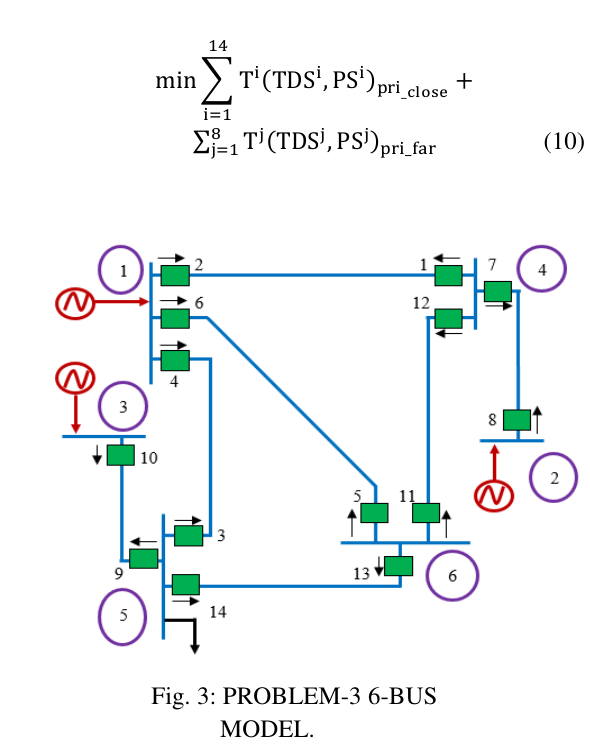
Fig. 3: PROBLEM-3